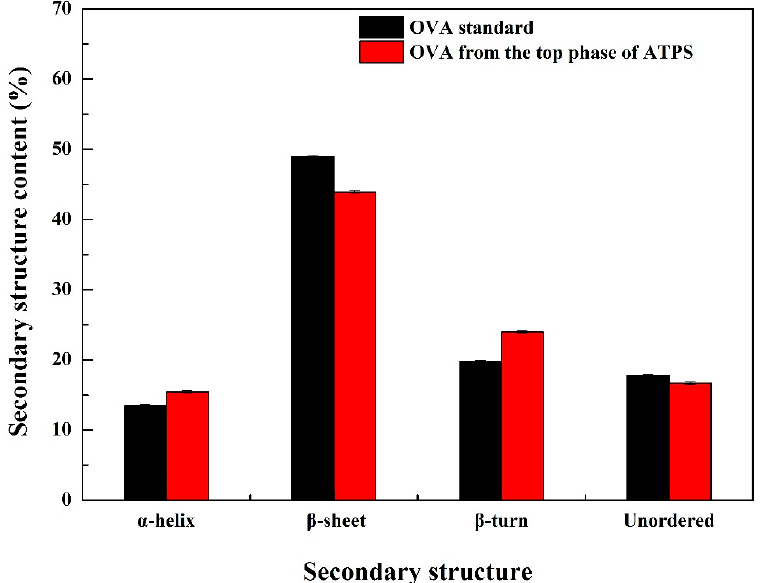
Figure 6. Fitting FTIR chart for OVA from the top phase of the ATPS.